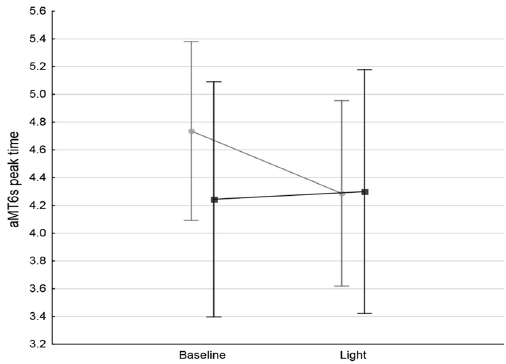
Figure 3. 6-sulfatoxymelatonin (aMT6s) acrophase in the PER3 4 /PER3 4 (light grey, n = 19) and PER3 5 /PER3 5 (dark grey, n = 11) subjects, before and after light administration. Effect of genotype: p = 0.646, time: p = 0.101, genotype * time: p =